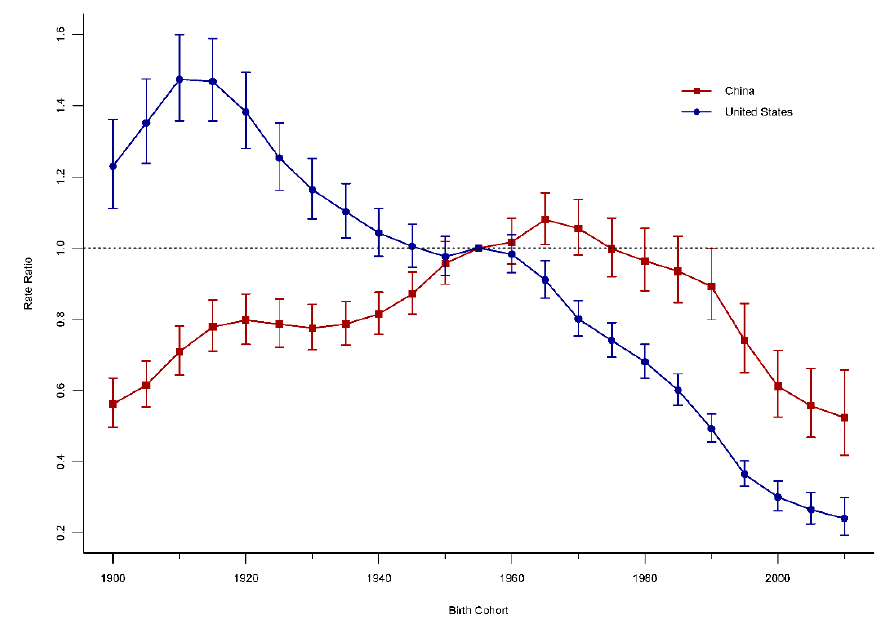
Figure 5. Cohort RRs of road injury mortality rate adjusted for age and period effects, comparing to the referent cohort (1955–1959) and the corresponding 95% CI.